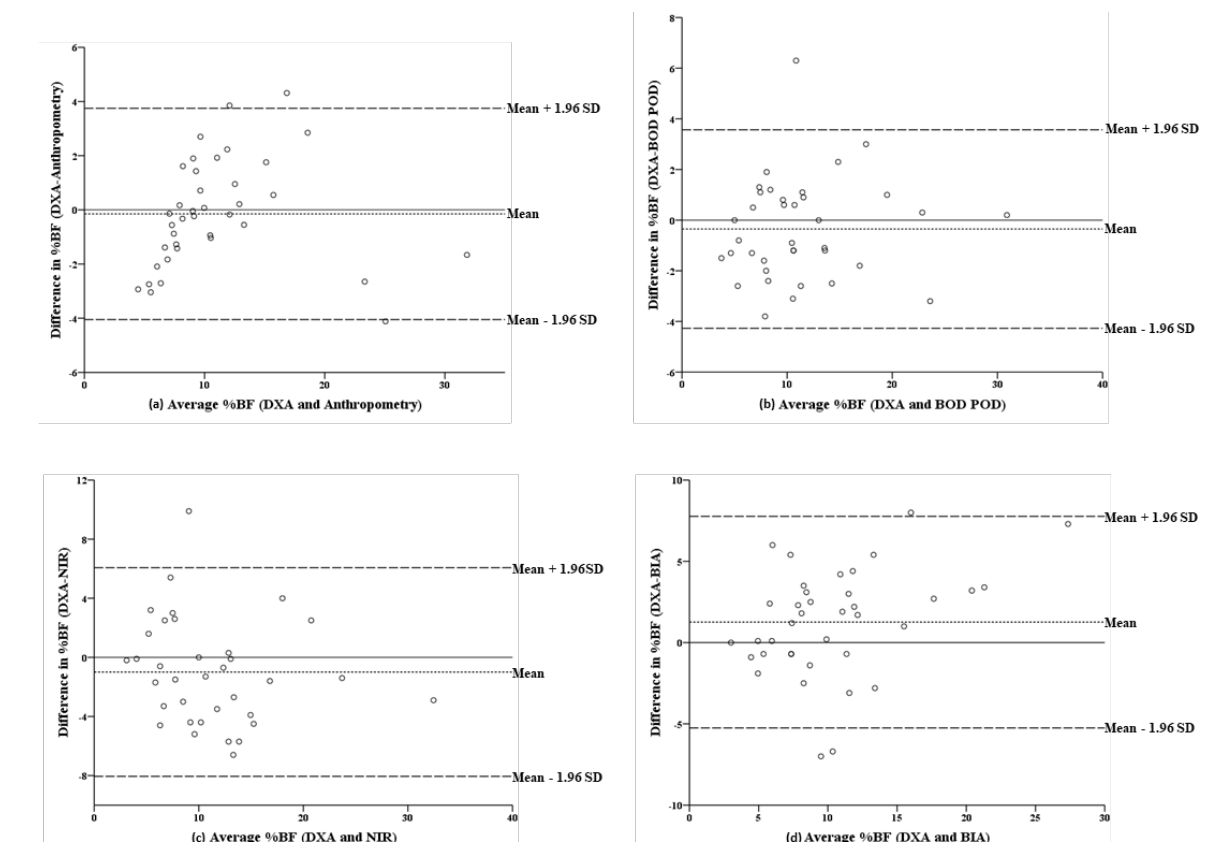
Figure 1. Bland–Altman plots representing the difference between DXA-derived %BF and %BF determined using ( a ) anthropometry, ( b ) BOD POD, ( c ) NIR and ( d ) BIA. The central dotted line represents the mean inter-methods difference. The upper and lower broken lines represent the 95% limits of agreement (inter-methods difference ± 1.96 SD of the differences). Abbreviations: %BF = percentage of body fat; DXA = dual-energy X-ray absorptiometry; BOD POD = air displacement plethysmography; NIR = near-infrared interactance; BIA = bioelectrical impedance analysis; SD = standard deviation.